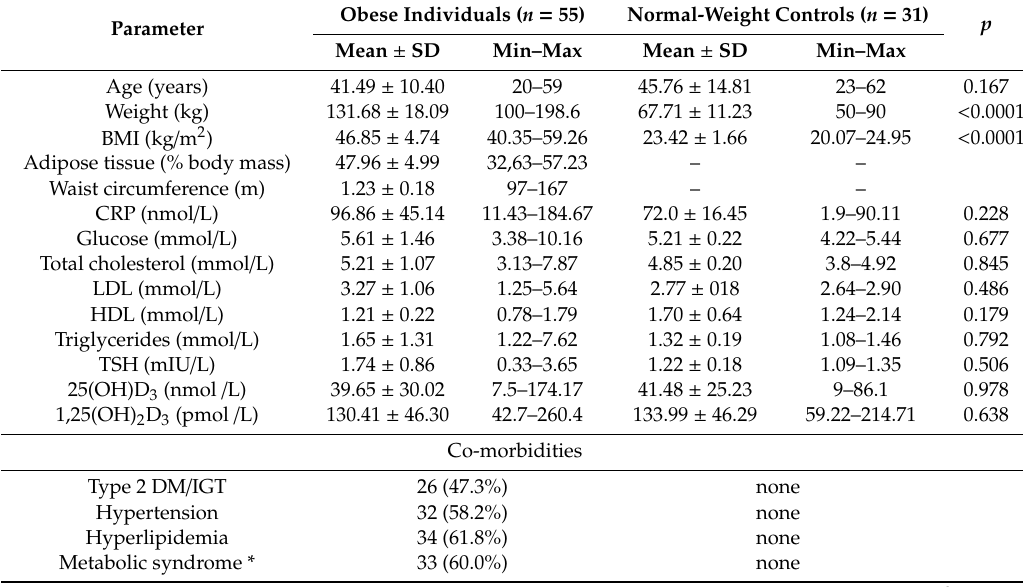
Table 1. Clinical and biochemical characteristics of study